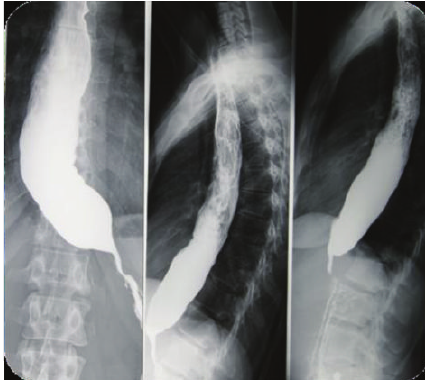
Figure 2: Barium swallow showing emptying defect with “bird beak” sign and narrowing at esophageal junction.